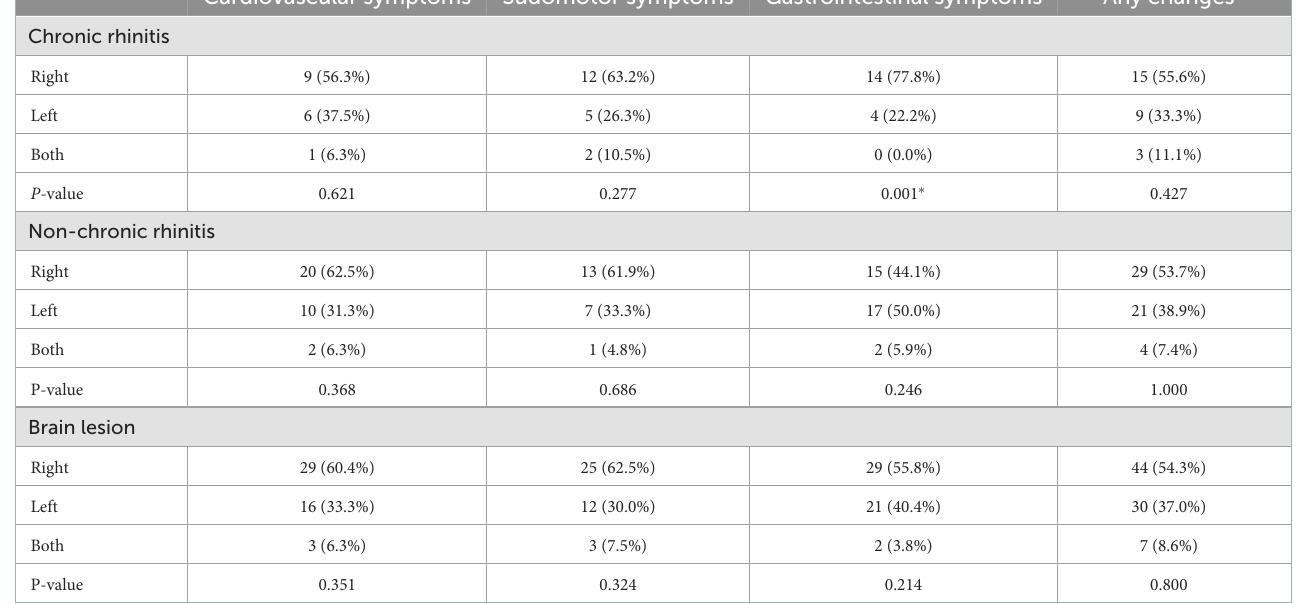
TABLE 4 Autonomic function evaluation by brain lesion. Cardiovascular symptoms Sudomotor symptoms Gastrointestinal symptoms Any